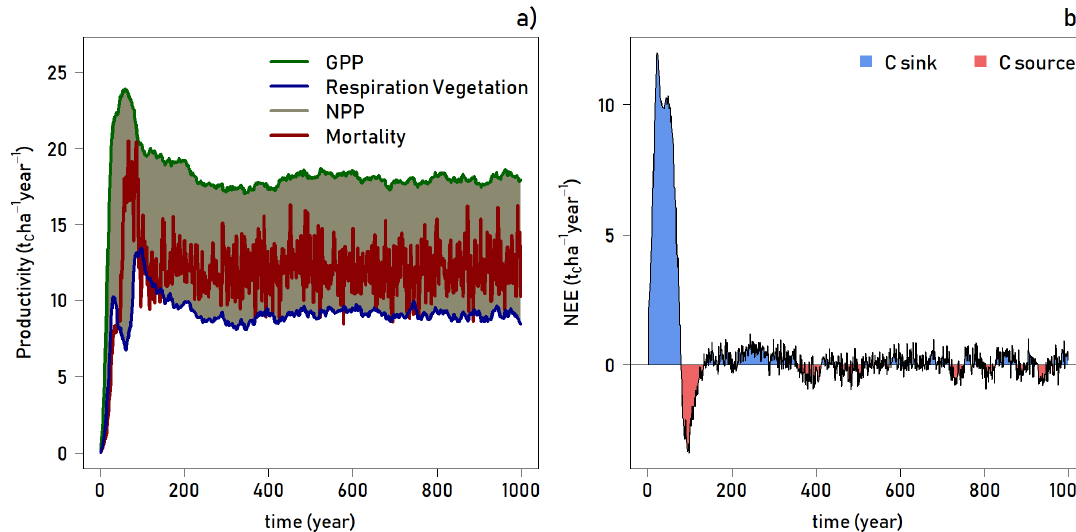
Figure 5. ( a ) Gross primary productivity (GPP), respiration, net primary productivity (NPP), and biomass mortality through time for the Madagascar rainforest simulation (50 ha forest area); ( b ) The net ecosystem exchange (NEE) time series for the Madagascar rainforest simulation. The shading refers to points in time where the simulated forest is a carbon source (blue) and a carbon sink (red) through the 1000-year timespan.